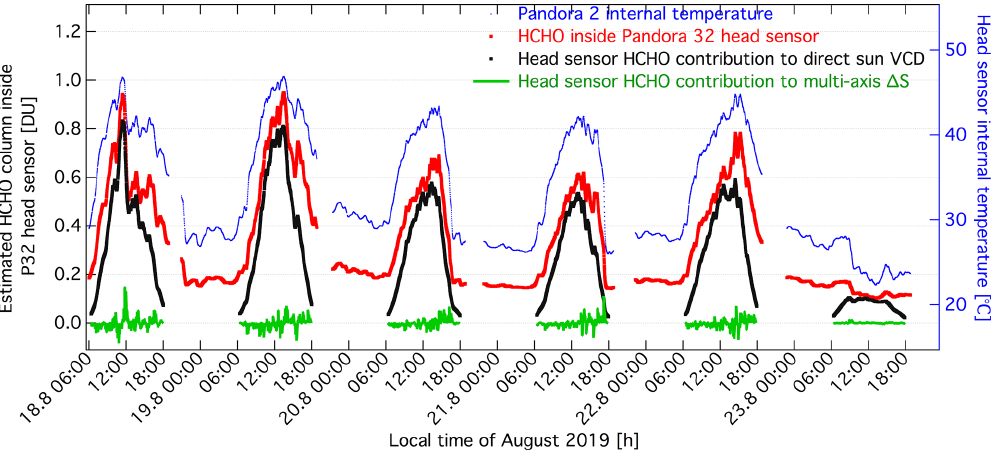
Figure 9. Subset of data from Fig. 8: estimation of HCHO column density inside Pandora 32 head sensor during deployment at GSFC/NASA, Greenbelt, MD, in August 2019 and its contribution to HCHO vertical column density measured in direct-sun and multi-axis